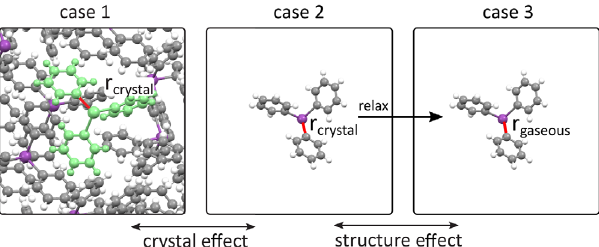
crystal effect and the structure effect onto Q CC . The average